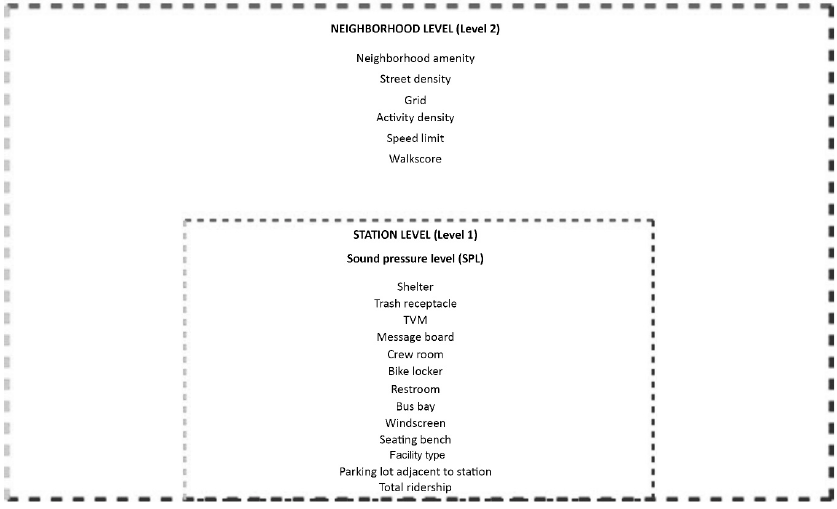
Figure 3. Conceptual hierarchical linear modeling (HLM) Nesting Structure for the Variables.